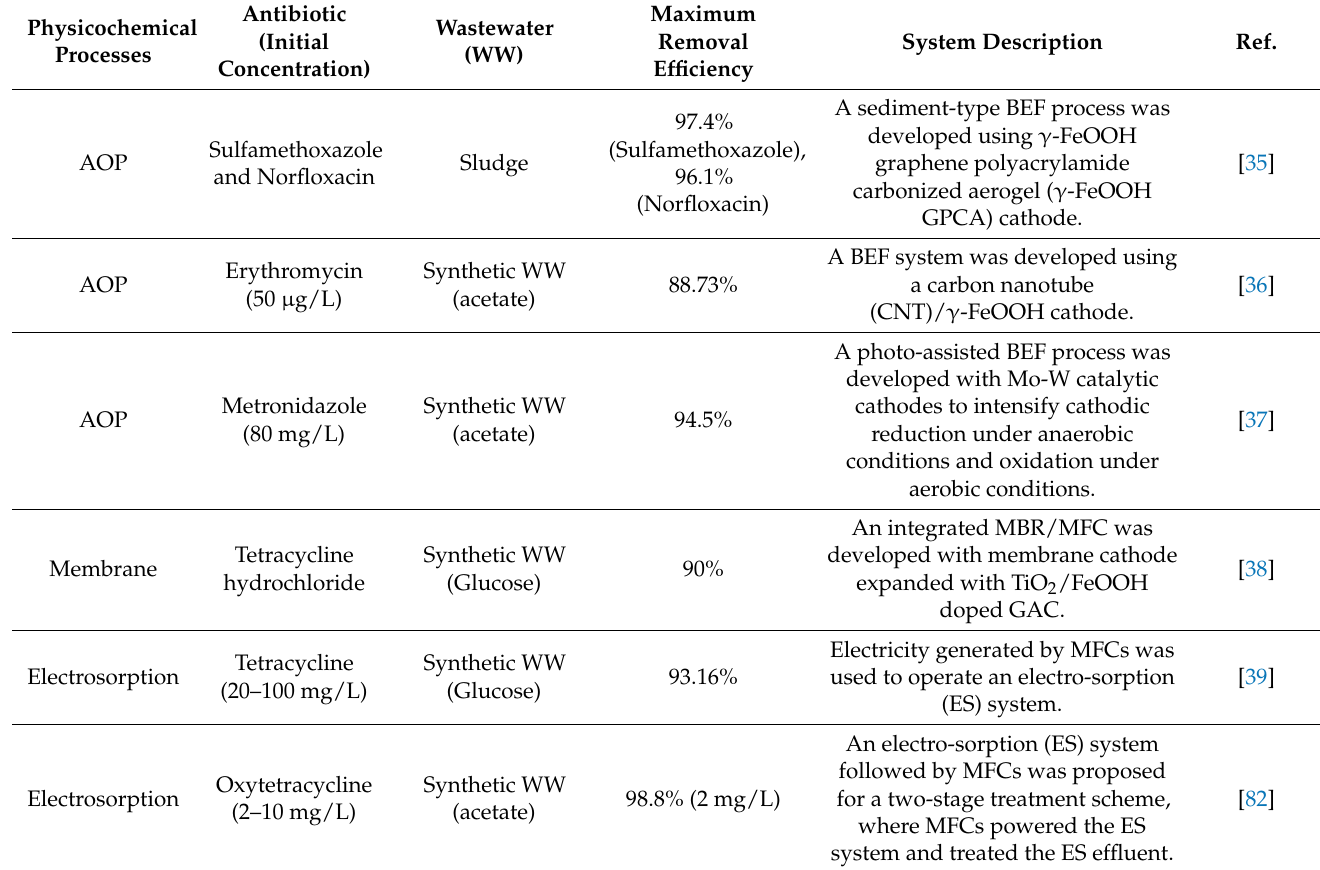
Table 3. Hybrid MFCs coupled with advanced physicochemical